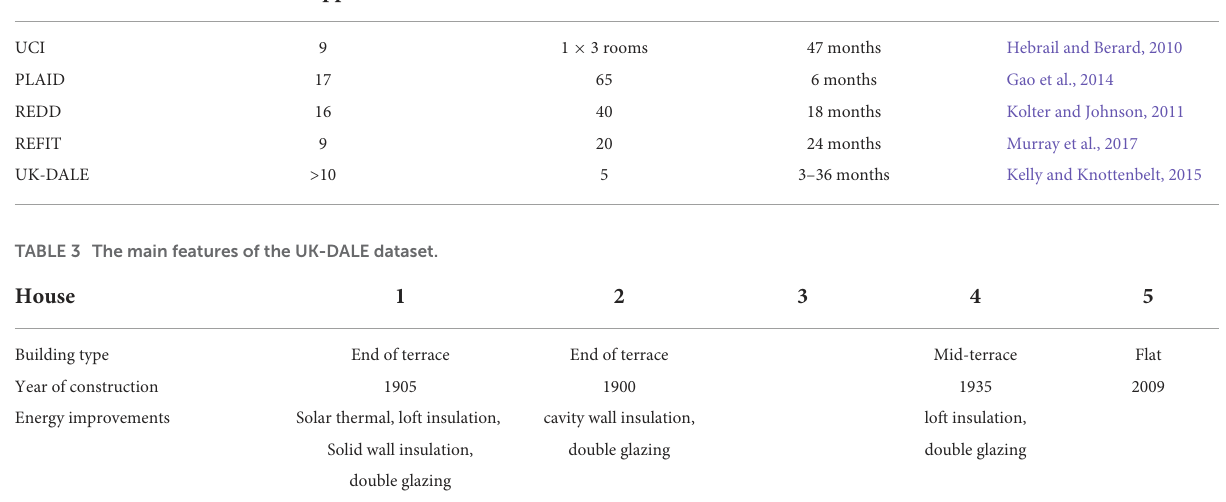
TABLE 2 Popular NILM and energy usage datasets.